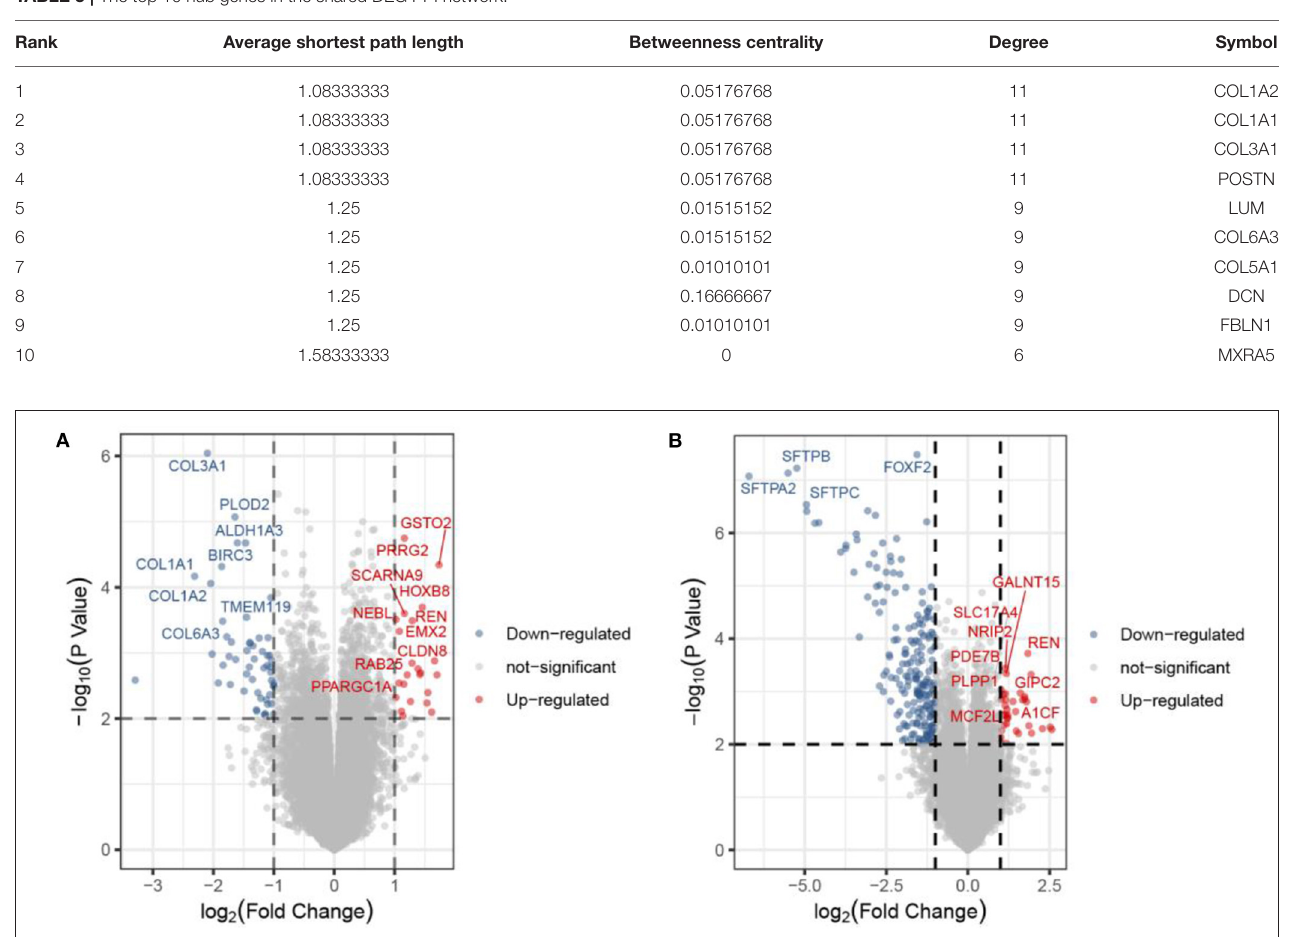
FIGURE 2 | Volcano plot of the DEGs in the primary ccRCC group compared with the metastatic ccRCC group from the GSE105261 (A) and GSE85258 (B) datasets. Each point corresponds to one gene.